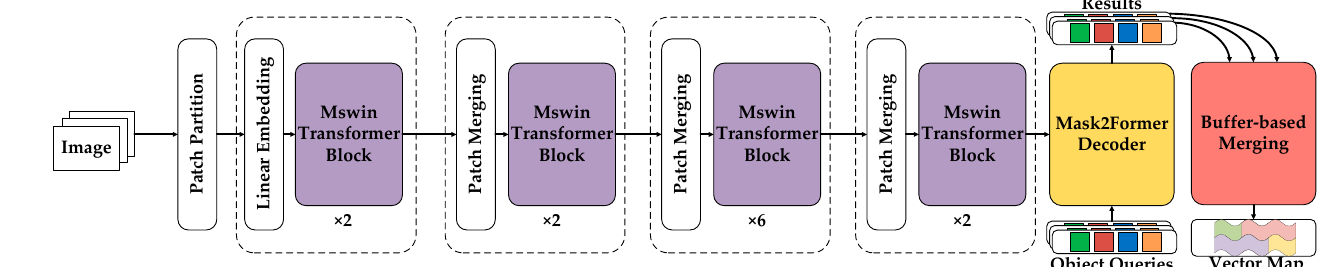
Figure 3. The overall architecture of the MSMTransformer and image merging process. The purple area is the Multi-Swin Transformer block, which is used to extract multi-scale information. The Multi-Swin Transformer block is a module based on the attention mechanism.